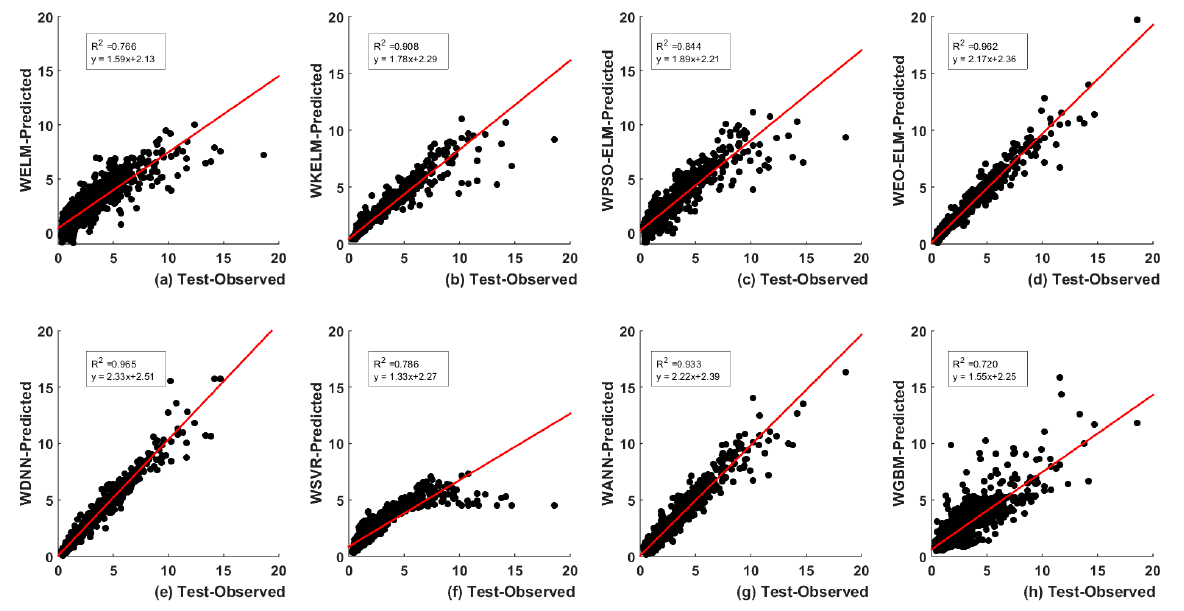
Figure 15. Prediction capability of the eight models in test case ( a ) WELM, ( b ) WKELM, ( c ) WPSO-ELM, ( d ) WEO-ELM, ( e ) WDNN, ( f ) WSVR, ( g ) WANN, and ( h ) WGBM for the catchment Fal at Tregony.